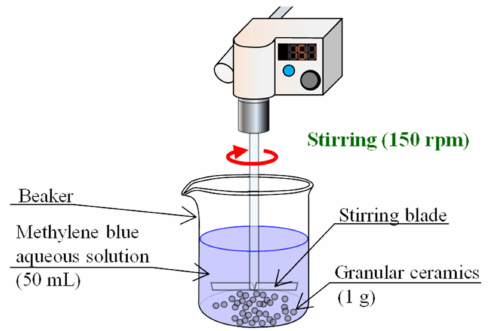
Figure 3. Schematic diagram of the dye adsorption